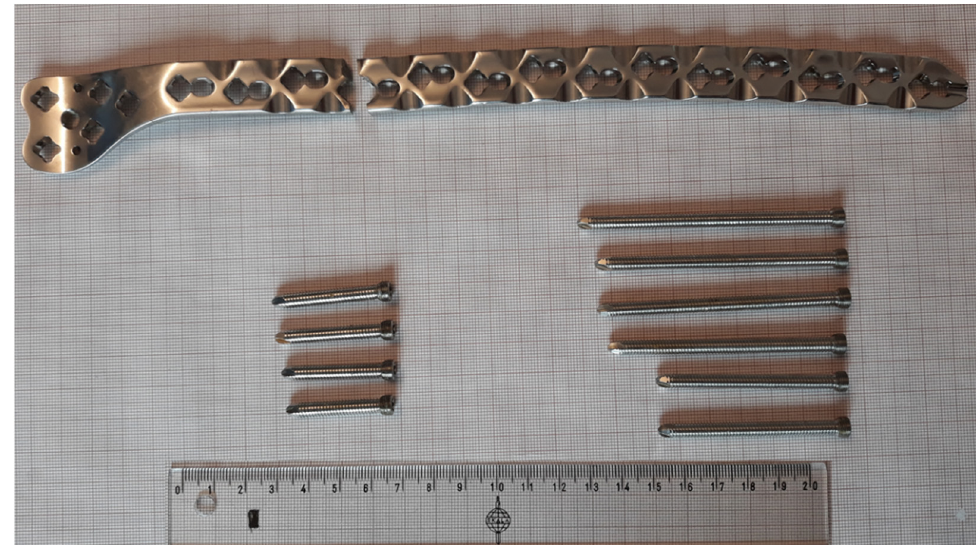
Figure 13. General view of the explanted steel femoral condylar plate. Table 5. Chemical composition of the steel femoral implant.